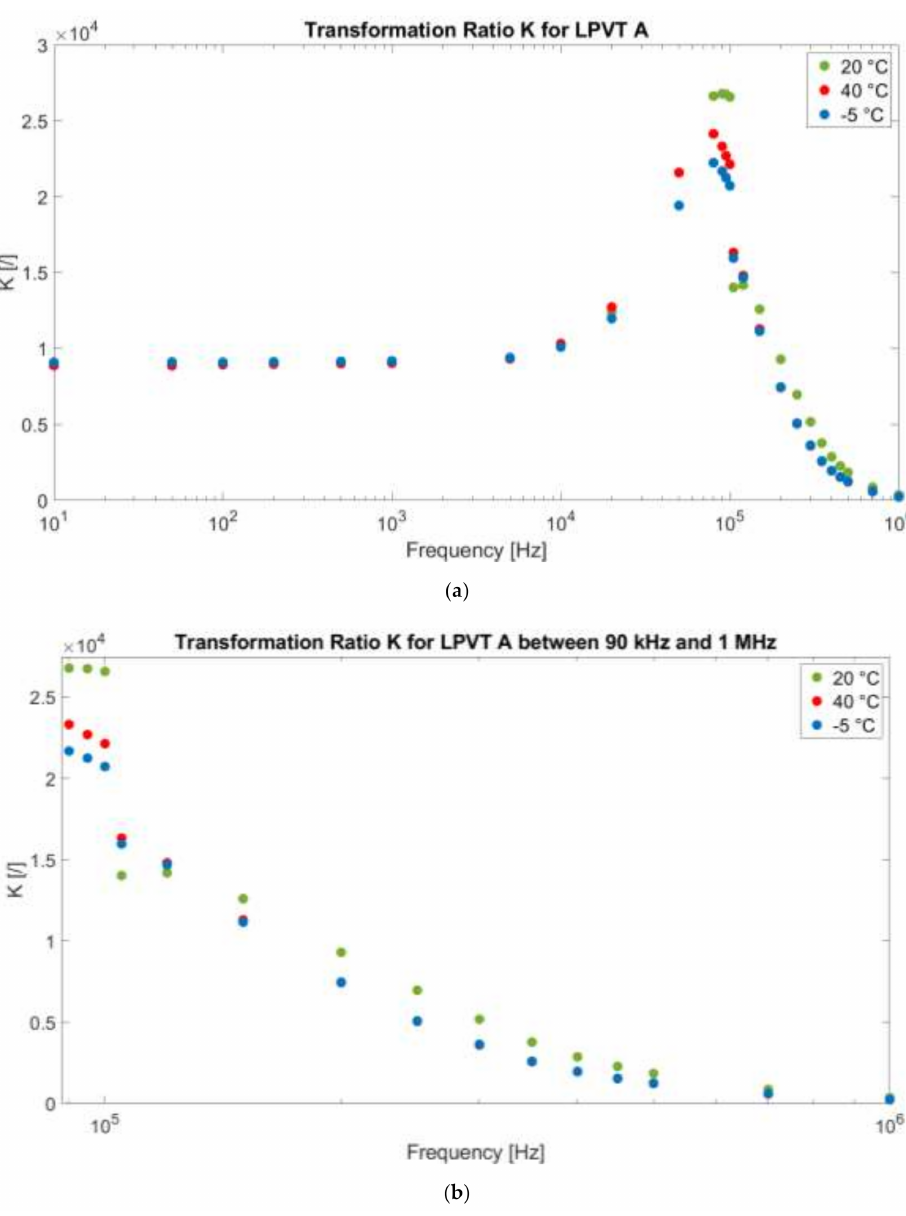
Figure 5. ( a ) Transformation ratio ( K ) as a function of the applied frequency f at 20 ◦ C, 40 ◦ C, and − 5 ◦ C for LPVT A. ( b ) A zoomed-in portion of the graph from 90 kHz to 1